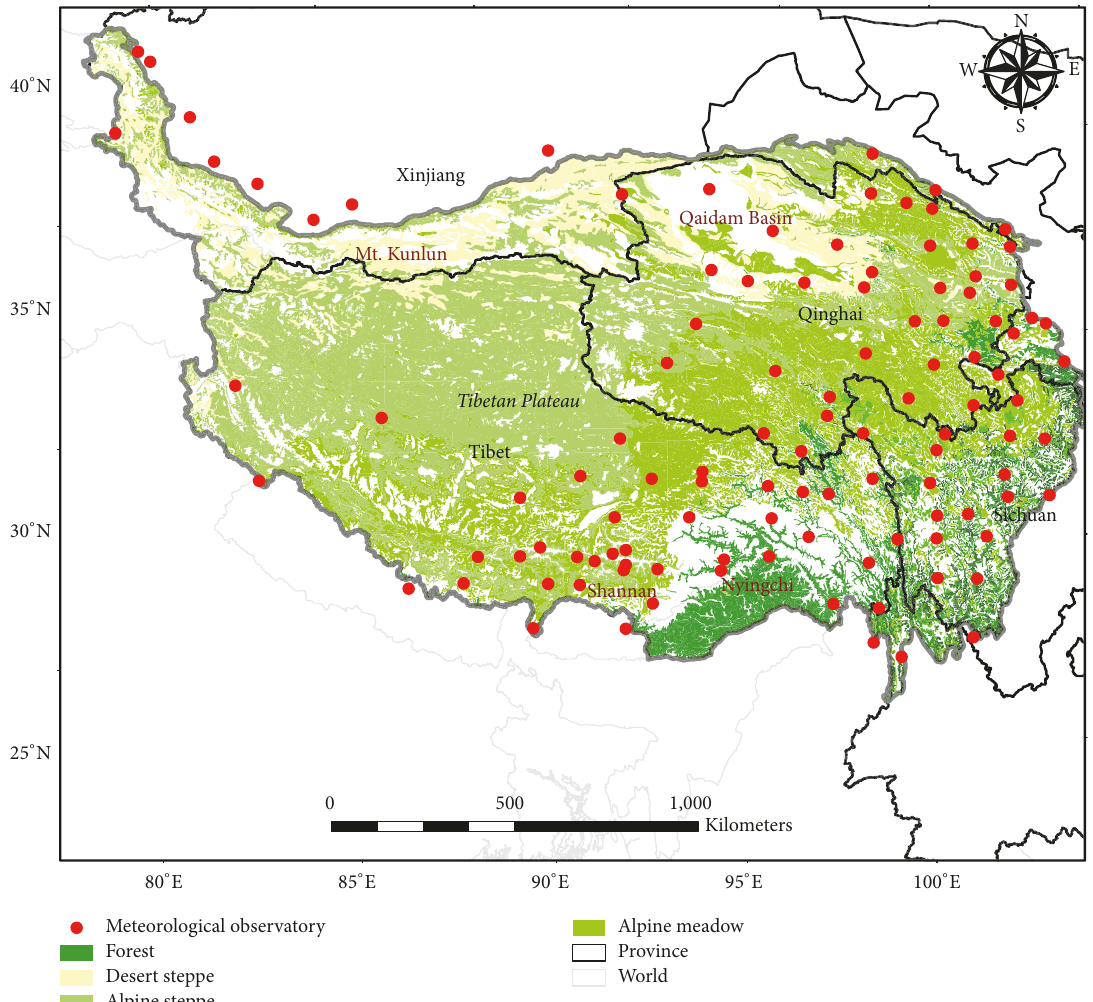
Figure 1: The study area across Tibetan Plateau. The ecosystems contained alpine meadow, alpine steppe, desert steppe, and forest.